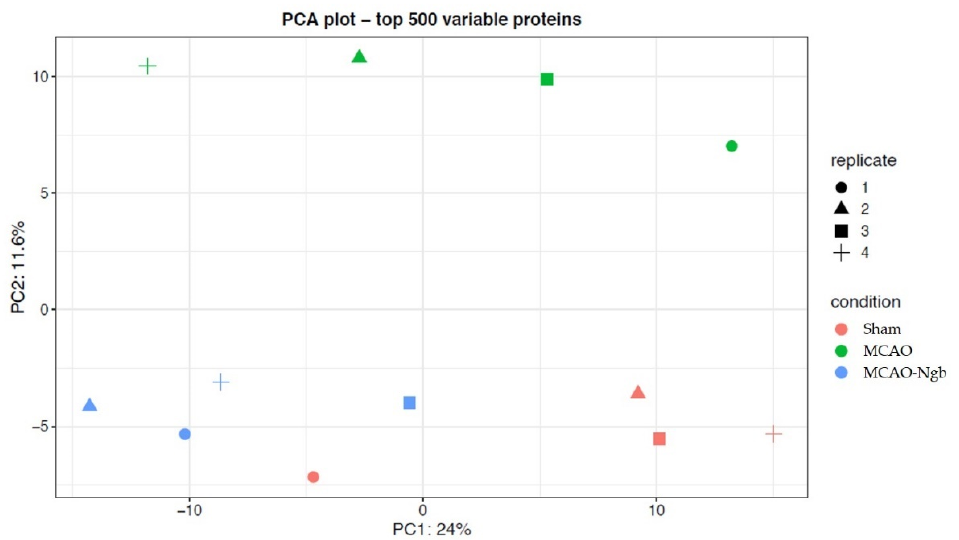
Figure 10. Quality control plot of the two first principal components (PCA) using the top 500 variable proteins among the three groups (sham, MCAO, and MCAO-Ngb). As shown, MCAO-Ngb animals were clustered closer to the sham control group than to the MCAO non-treated group.